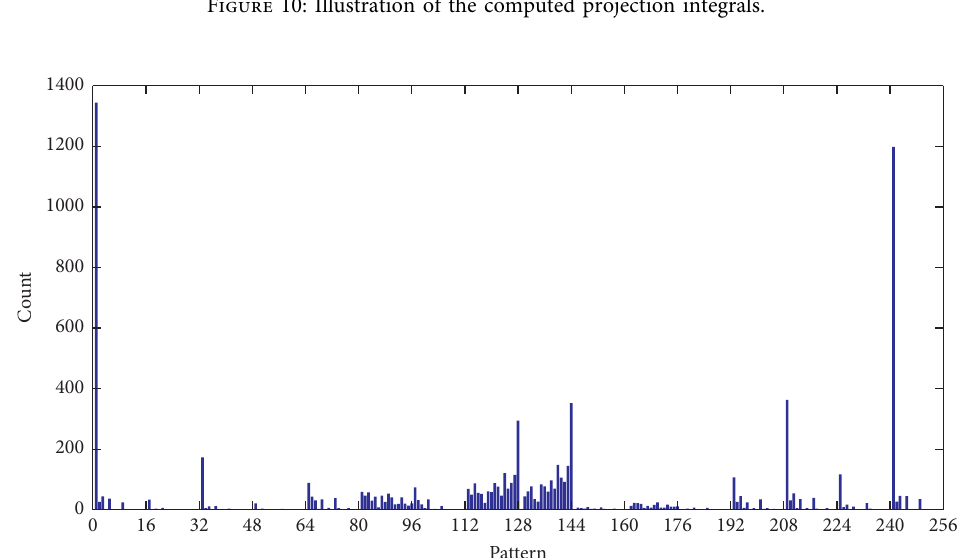
Figure 11: Illustration of the ARCS-LPB’s